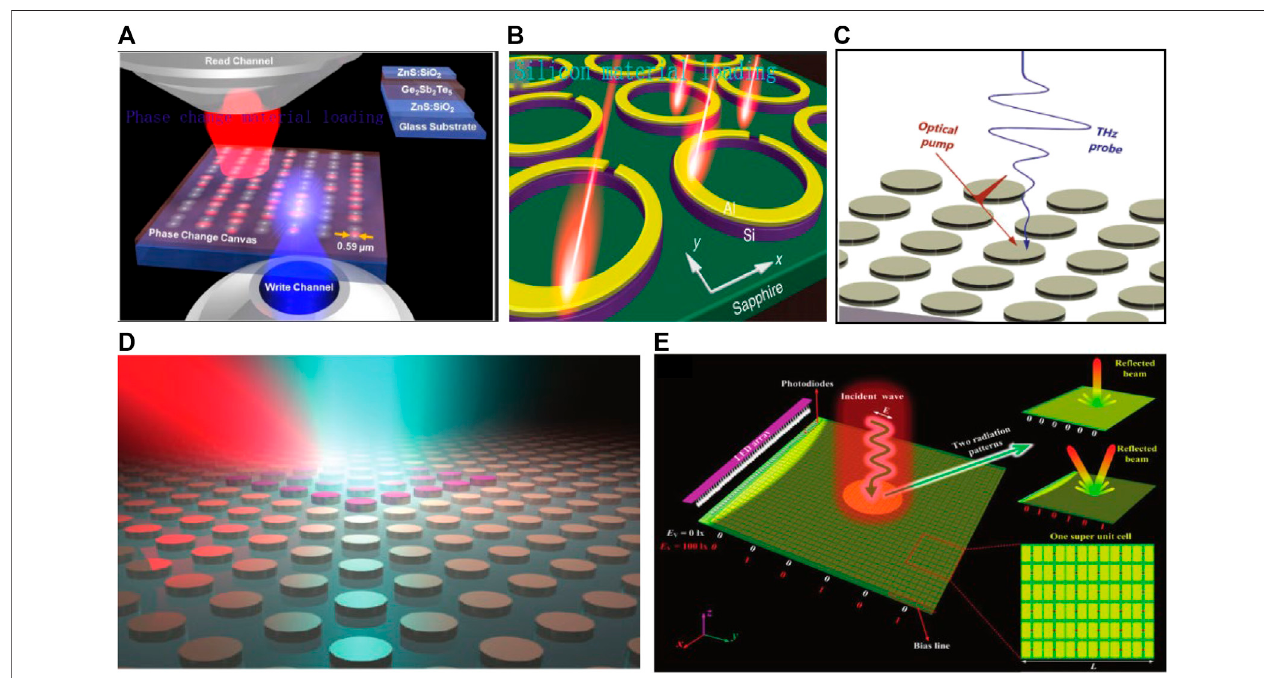
FIGURE 6 | Optically recon fi gurable metasurface. (A) Loaded with phase change material [131], (B) loaded with additional silicon ring layer [132], (C) loaded with ion-implanted silicon layer [133], (D) loaded with speci fi c dielectric materials [134], and (E) loaded with photodiodes [135].